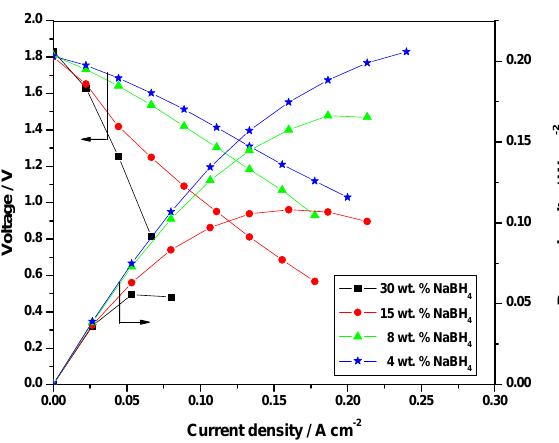
Figure 4. Polarization data for the DBFC with 4 wt. %, 8 wt. %, 15 wt. % and 30 wt. % NaBH as anolyte and 8 M H 4